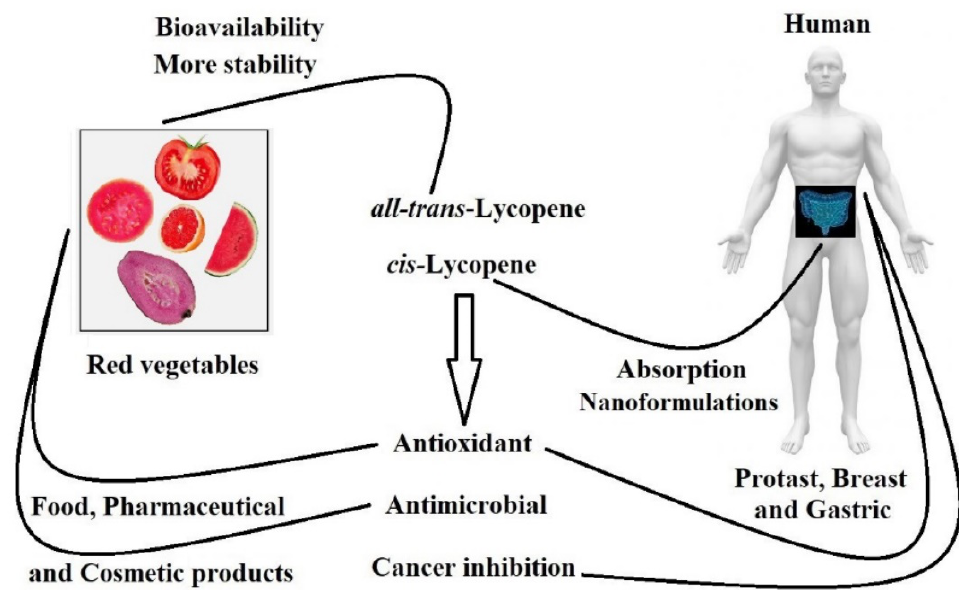
Figure 1. Representation of bio-availability and functions of lycopene in humans as well as products from foods, pharmaceutical and cosmetic products.